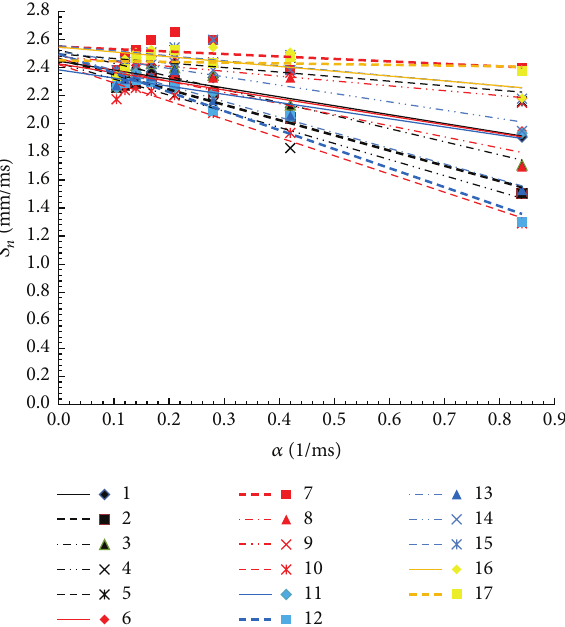
Figure 9: Flame speed of ethanol of 95.5%v at 𝜙 = 1.1 , 𝑇 = 305 K, and 𝑃 = 1 atm. Repetition performed 17